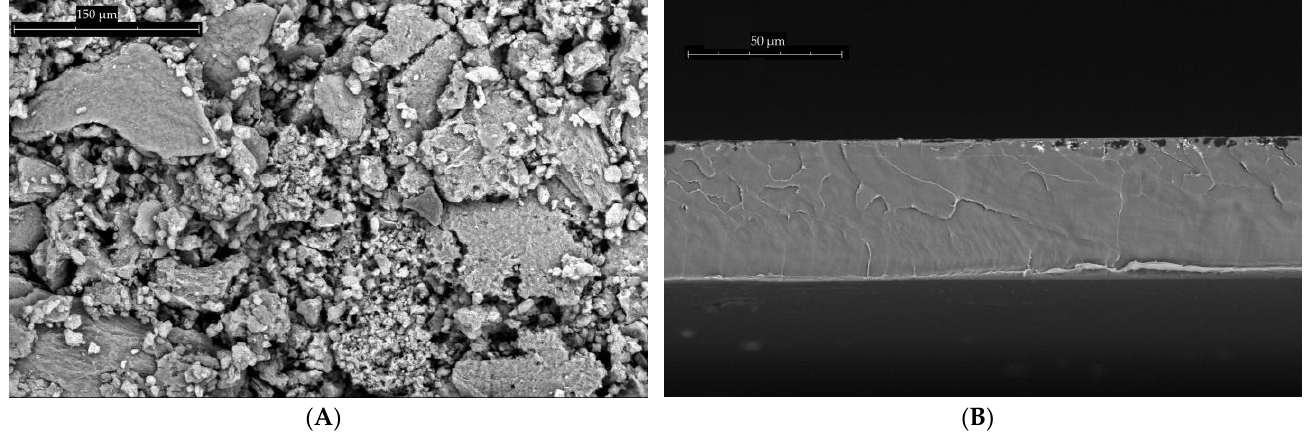
Figure 6. ( A ) SEM of the PHMGH-MMT biocide; ( B ) the cross section of the PS film with the addition